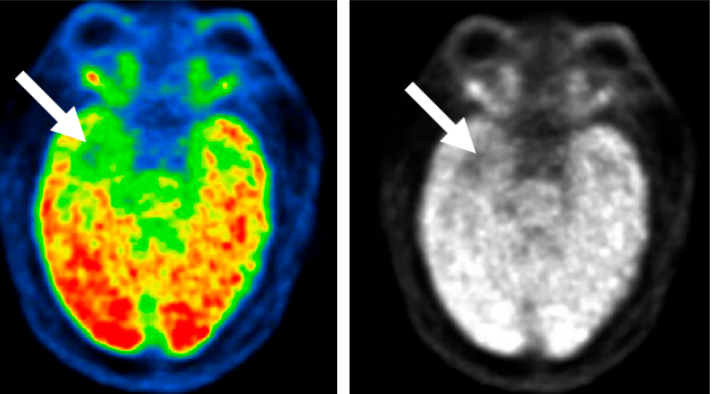
Figure 3. Interictal FDG PET (fluorodeoxyglucose positron emission tomography) scan. Decreased glucose uptake in the right temporal area (arrows) compared to the left side, in a patient with right mesial temporal lobe epilepsy (MTLE).